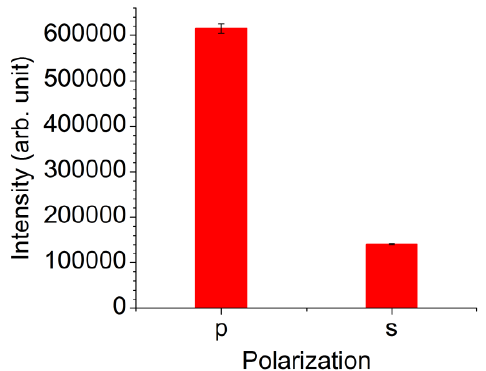
Figure 4. Luminescent intensities of the CNT dispersion sample with a concentration of 25 μg/mL measured using a V-trench biosensor. The excitation light was p- or s-polarized. The error bars indicate the standard errors.